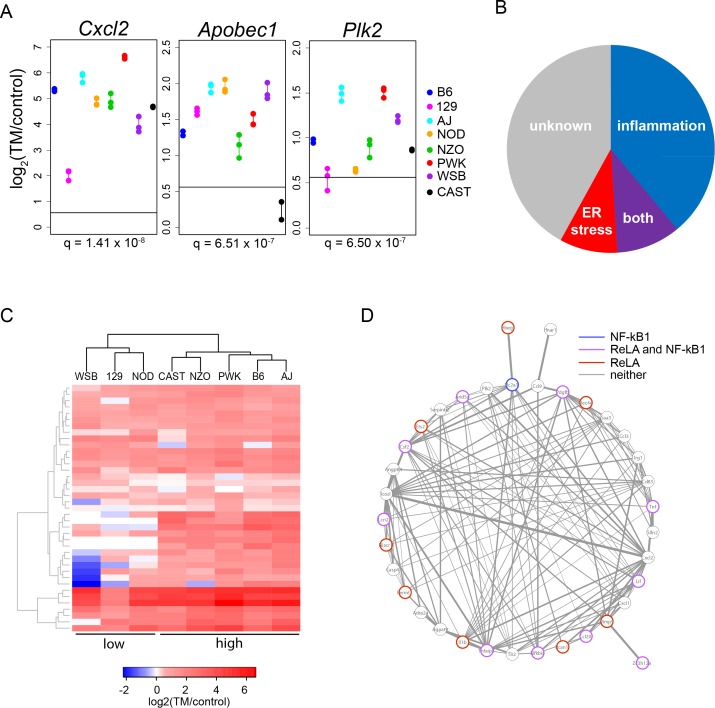
ER stress-induced genes with a strain effect are enriched for inflammation functions.(A) The top three genes with the strongest strain effect. Horizontal line represents 1.5 fold. For each strain (different colors), all biological replicates are displayed as points connected by a vertical line. Horizontal line represents 1.5 fold; q = FDR correction of the strain effect. (B) Literature search identifies the proportion of genes with inflammation functions, ER stress functions, inflammation and ER stress functions (both), or unknown ER stress functions in the 100 genes with the strongest strain effect (FDR <0.01%). (C) Cluster analysis indicates that strains are either in a low (WSB, 129, and NOD) or high (CAST, NZO, PWK, B6, and A) inflammation group. Cluster analysis was performed with the 39 inflammation genes among the 100 genes with the strongest strain effect. For gene identities see S1 Fig. (D) Correlation network showing that inflammation genes are highly correlated in their response to ER stress. Edge thickness represents the correlation coefficient between the two nodes. Only significant pairwise correlations are displayed (Spearman’s; P < 0.05). Genes that contain ReLA and NF-kB1 transcription factor binding sites are color coded. All pairwise correlations can be found in S4 Table. TM: tunicamycin.